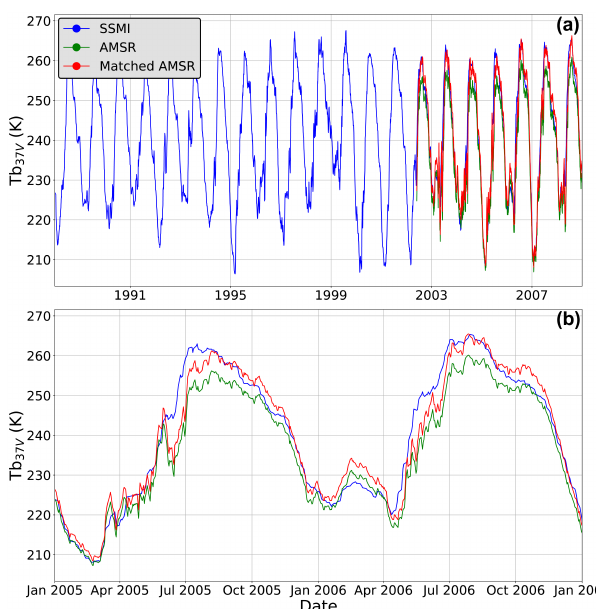
Figure 2. (a) Sample time series showing SSMI (blue) and AMSR-E (green) Tb 37V frequencies, with linearly matched mod- ified AMSR-E Tb (red), 1987–2009. Data are taken from 71.25E, 36.75N (see Fig. 1). (b) The same data as panel (a) but for two seasons